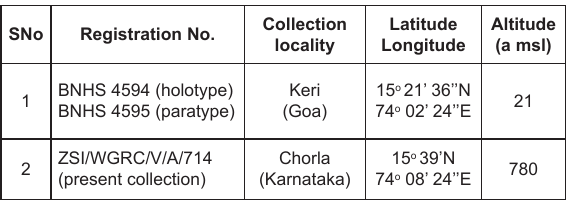
Table 1. Collection localities for G. goaensis in Goa State.